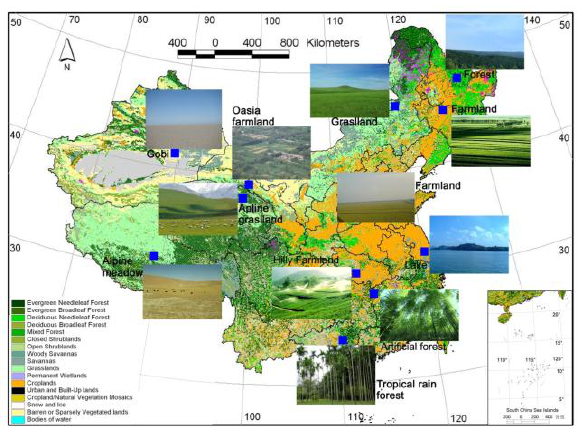
Figure. 5 Anchor sites and their vegetation types in the validation network in